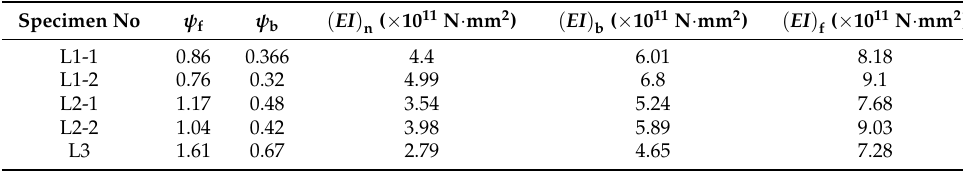
Table 7. Composite coefficients and flexural stiffness of composite beams.